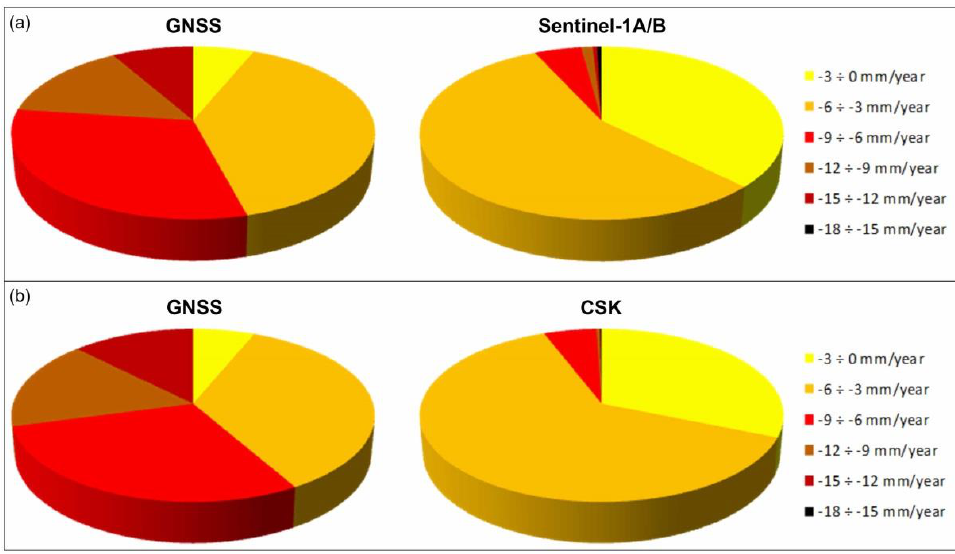
Figure 6. Classification of the GNSS and InSAR points based on the LOS velocities considering six classes from 0 mm/year to − 18 mm/year: ( a ) GNSS and Sentinel-1 points; ( b ) GNSS and CSK points. The displacement time series of three NPS GNSS points, characterized by different LOS velocities and located in different portions of the PRD area (065708, 077904, and 077902, Figure 1) were compared with the closest Sentinel-1 and CSK points (Figure 7), to test the reliability of the PODELNET network. The dashed lines show the linear deformation rate between the subsequent NPS GNSS observations, which were consistent with the trend of the InSAR time series.